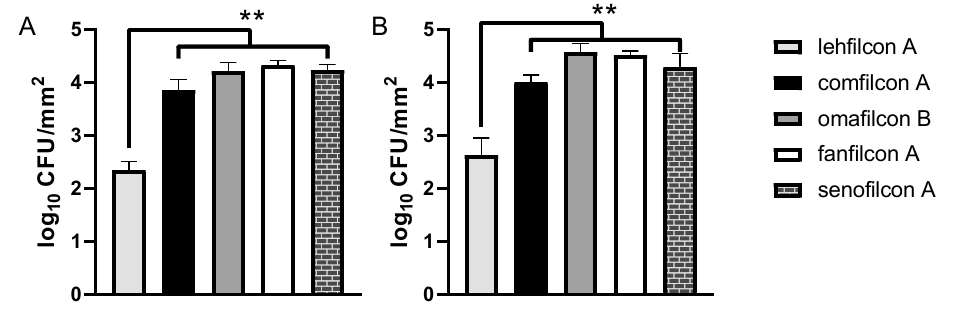
Figure 3. Fluorescent surface staining of live S. marcescens does not affect contact lens adhesion trends. ( A ) Adhesion assay using S. marcescens MCC 7246 left unstained prior to exposure to soft contact lenses ( n = 6 per lens type) in MOPS minimal media containing 10% FBS. ( B ) Adhesion assay using S. marcescens MCC 7246 stained with TAMRA-SE prior to exposure to soft contact lenses ( n = 6 per lens type) in MOPS minimal media containing 10% FBS. Graphs depict the average log density of cells recovered after adhesion (log CFU/mm 2 ± S.D.). ** indicates p < 0.0001 for comparison to lehfilcon A.